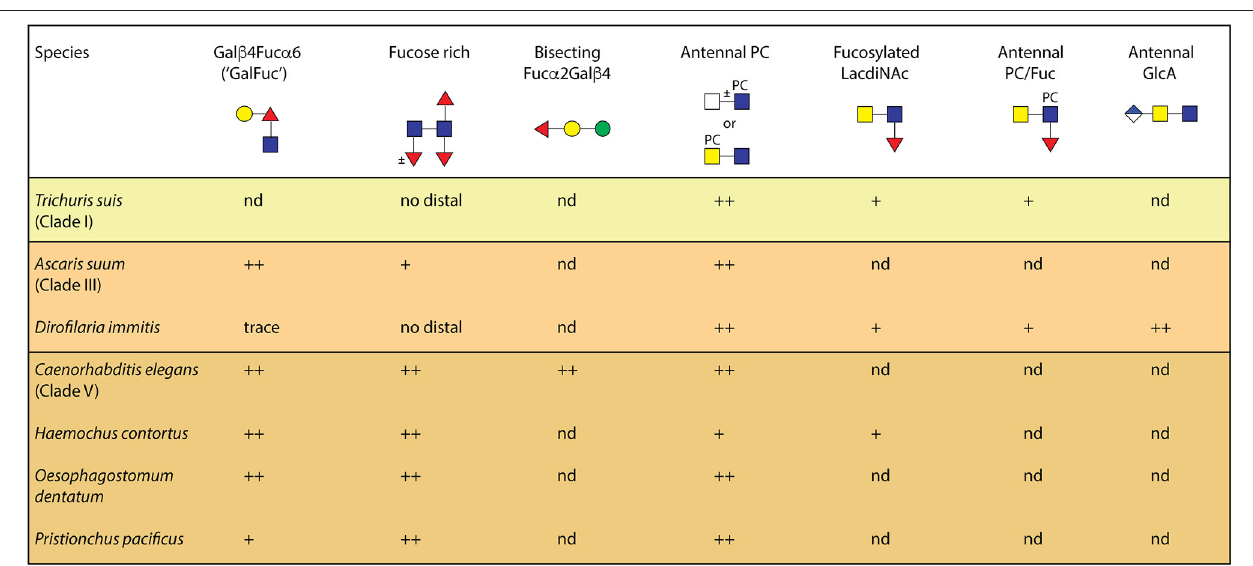
FIGURE 5 | A comparison of N-glycan epitopes in different nematodes. This summary is based on our own work using an off-line HPLC-MALDI-TOF-MS workflow and shows the proven occurrence of various core and antennal modifications in nematodes. Additionally, whereas one methylated core α 1,3-fucosylated glycan was detected in P. pacificus (Yan et al., 2015c), methylated or α -galactosylated fucose and mannose residues are present in C. elegans and O. dentatum (Yan et al., 2015b; Jiménez-Castells et al., 2017); glucuronylated N-glycans in nematodes have been only found thus far in D. immitis (Martini et al., 2019). The clades are those as defined by Blaxter (2011); “nd” signifies not detected to date, while ++ / + is an indication of the level of expression of the relevant